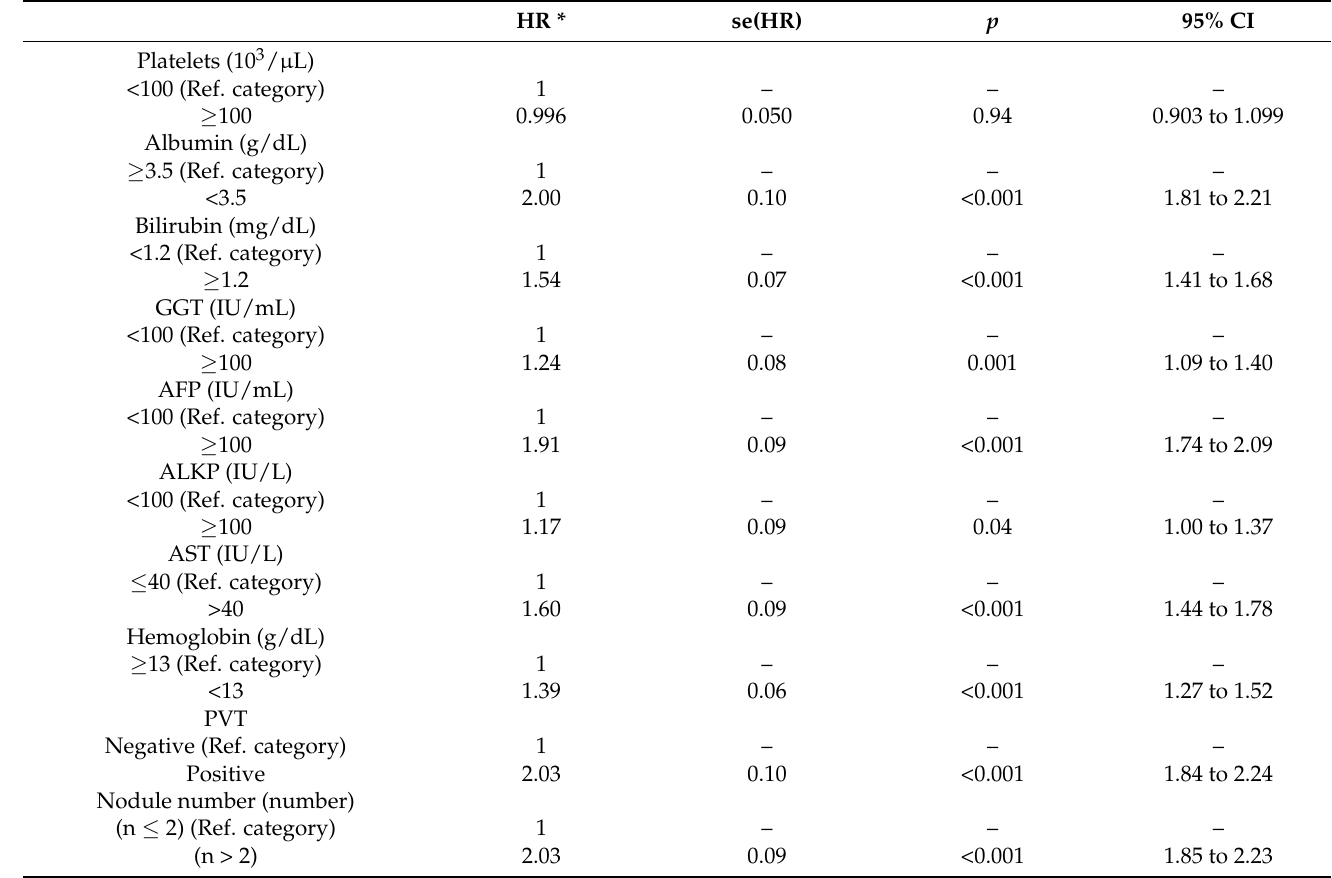
Table 1. Multiple Cox proportional hazard models for death on clinical parameter categories in hepatocellular carcinoma (HCC) patients. HR *